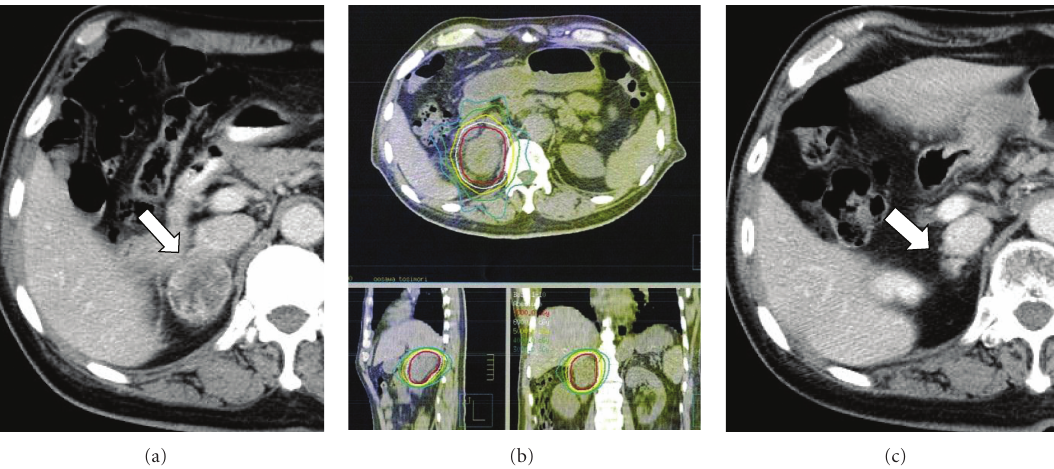
Figure 1: (a) CT of right adrenal metastasis (arrow) before SBRT. (b) Dose distribution made with 10 noncoplanar beams for SBRT. Isodose lines show total doses (in 25 fraction) of 70Gy, 60 Gy, 50 Gy, and 40Gy, in 10 fractions, respectively, from the innermost area. The 30-Gy isodose line overlapped at the second portion of the duodenum with the 40-Gy isodose line of the SBRT for right adrenal metastasis, resulting in grade 2 duodenitis 1 month after SBRT. (c) CT at 6 months after SBRT, showing partial response of the lesion (arrow).